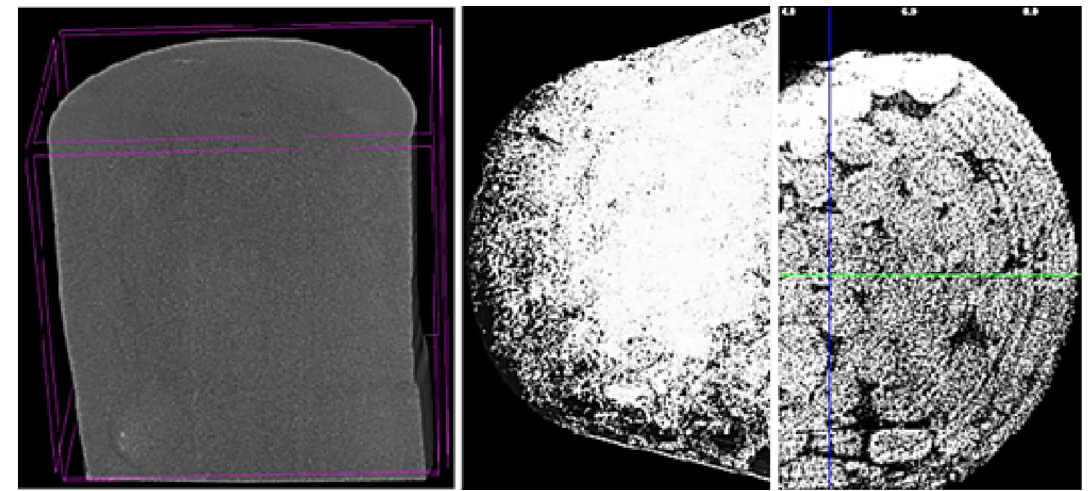
Fig. 9 3-D model of core sample